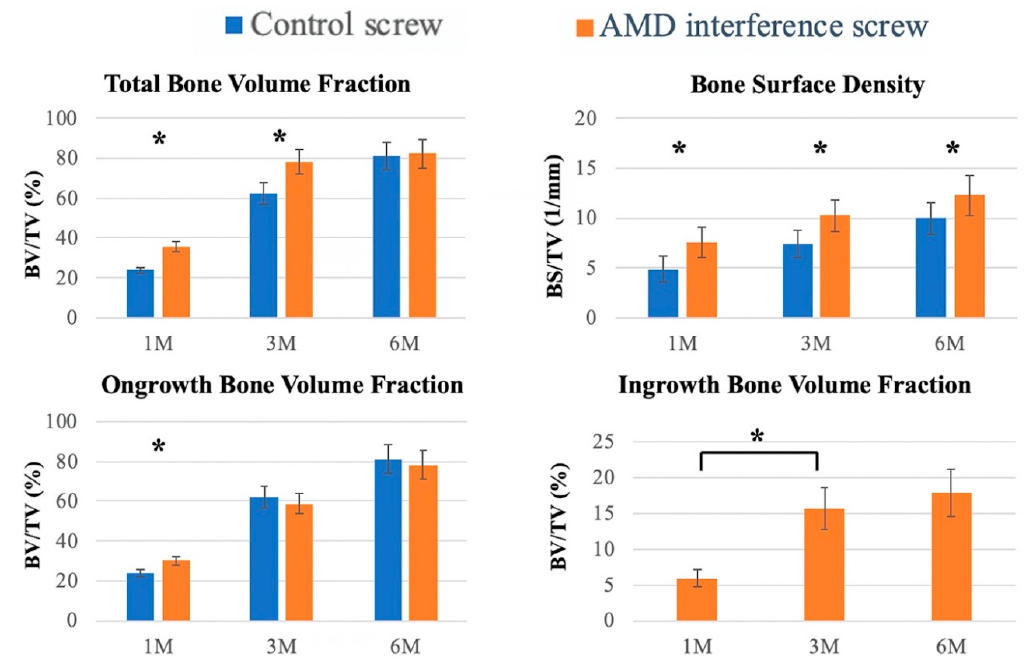
Figure 5. Quantitative evaluation of bone volume between bone and screw. interfaces. Micro-CT was used to evaluate the bone ingrowth after screw implantation. Tissue volume (TV: mm 3 ), bone volume (BV: mm 3 ), and bone surface (BS: mm 2 ) were retrieved from 100 to 1000 µ m above the implant. Bone volume fraction (BV / TV) and bone surface density (BS / TV) represent the bone volume rate and bone tissue surface rate, respectively. Ongrowth bone volume denotes the bone outside the control screw, and ingrowth bone volume denotes bone mass inside the surface of the implant; the error bar represents the standard deviation, and * denotes statistical significance between the two groups.